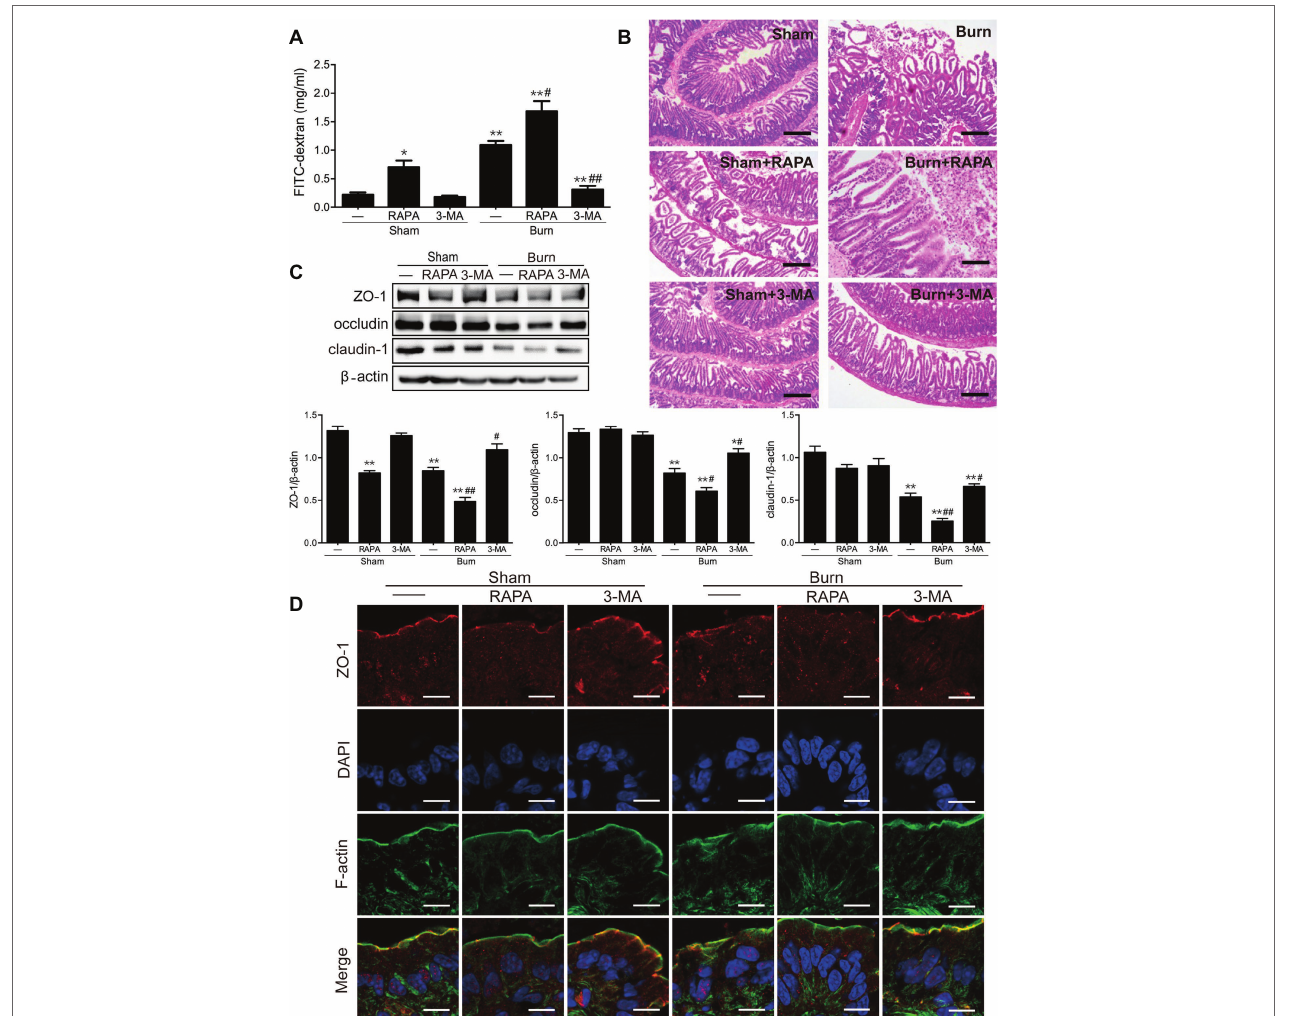
FIGURE 4 | Severe burn-induced intestinal epithelial TJ barrier dysfunction is exacerbated by rapamycin and ameliorated by 3-MA. Mice were treated as described in Figure 3 . (A) Intestinal permeability to 4.4 kDa FITC-dextran was measured at 6 h after sham burn or burn injury as described in “Materials and Methods.” Data represent mean ± SEM. * p < 0.05, ** p < 0.01, compared with sham-burn group ( n = 5). # p < 0.05, ## p < 0.01, compared with burn group ( n = 5). (B) Hematoxylin and eosin staining of distal ileal segments was performed at 6 h following sham burn or 30% TBSA burn. Data are representative of five independent experiments. Scale bar = 200 μm. (C) Immunoblot was performed to determine the expression of ZO-1, occludin, and claudin-1, with β -actin as loading control. Data represent mean ± SEM. * p < 0.05, ** p < 0.01, compared with sham-burn group ( n = 5). # p < 0.05, ## p < 0.01, compared with burn group ( n = 5). (D) ZO-1 was stained by immunofluorescence assay. Data are representative of five independent experiments. Scale bar = 20.0